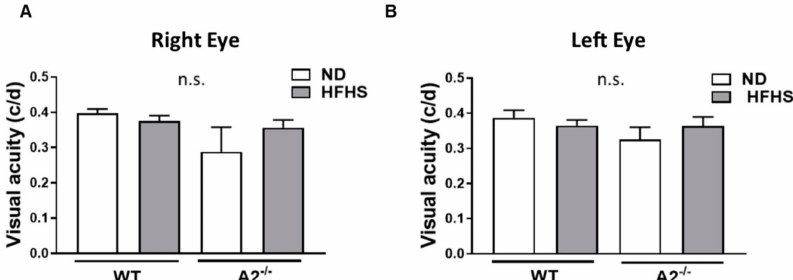
Figure 7. High-fat, high-sucrose (HFHS) diet and arginase 2 (A2) deletion did not a ff ect visual acuity. Visual acuity threshold was measured as the optokinetic tracking response and recorded as cycles / degree (c / d) in wild-type (WT) and A2 − / − mice fed the normal diet (ND) or HFHS diet for 16 weeks ( A , B ) ( n = 5–6 per group) n.s. = not